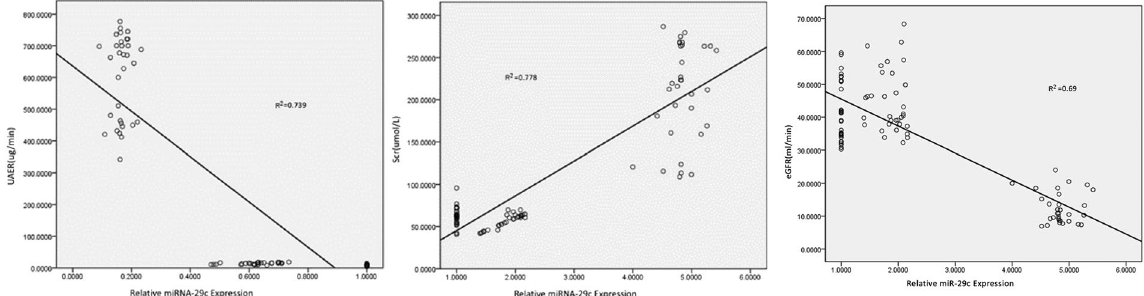
Figure 3. The Correlations between miRNA-29c Levels and Other Clinical Parameters. ( A ) The Correlations between miRNA-29c Levels and UAER. ( B ) The Correlations between miRNA-29c Levels and Scr. ( C ) The Correlations between miRNA-29c Levels and